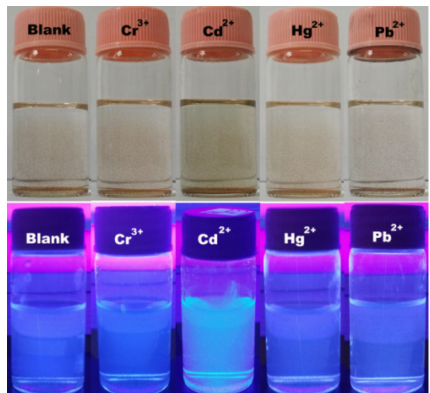
Figure 7. Changes in color ( top ) illuminated by natural light and fluorescence ( bottom ) illuminated with a fluorescent lamp ( λ ex = 352 nm, 8 W) of Fe 3 O 4 @SiO 2 -BPMA upon the addition of Me n + (Me n + = Cr 3 + , Cd 2 + , Hg 2 + and Pb 2 + ) ([Fe 3 O 4 @SiO 2 -BPMA] = 0.1 g / L; [Me n + ] = 10 − 5 mol / L; V = 6 mL, V acetonitrile / V water = 4 / 1).